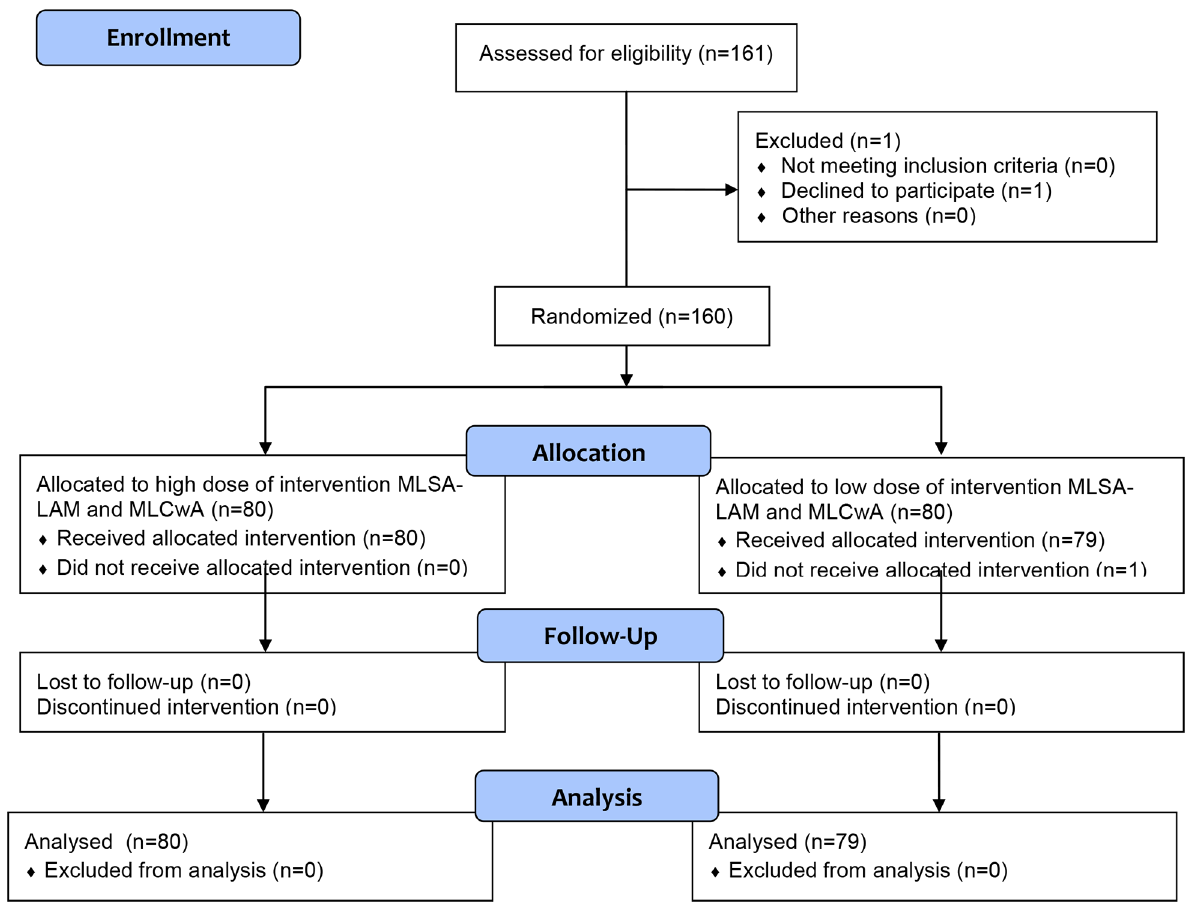
Figure 1. CONSORT flow diagram, Phase II, Stage C-1 Trial.